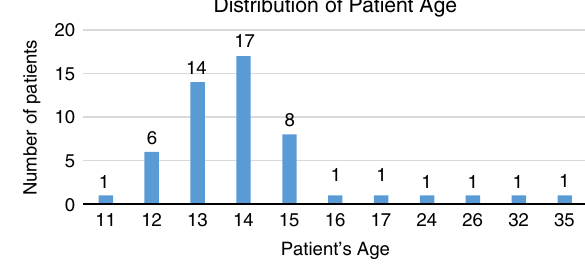
Figure 2. Distribution of patient age.